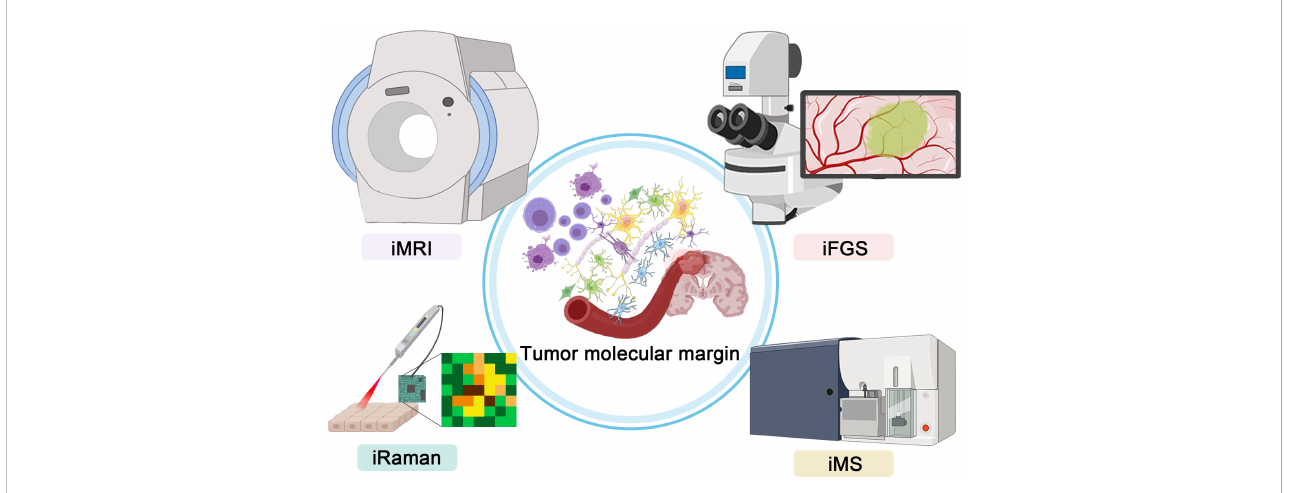
FIGURE 1 Graphical abstract showing the four intraoperative technologies for precise depictions of malignant glioma